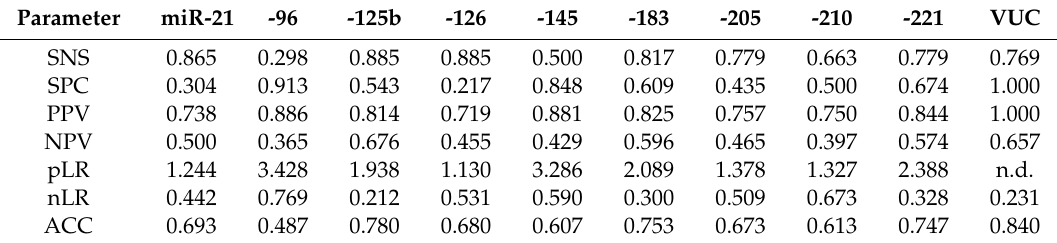
Table 4. Diagnostic performance of the miRNAs and VUC as single markers.